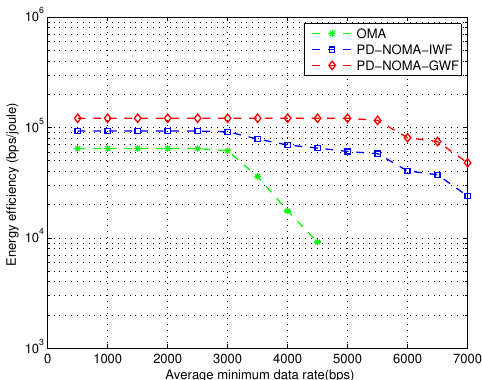
Figure 7. Performance of energy efficiency with different minimum data rate requirements of cellular